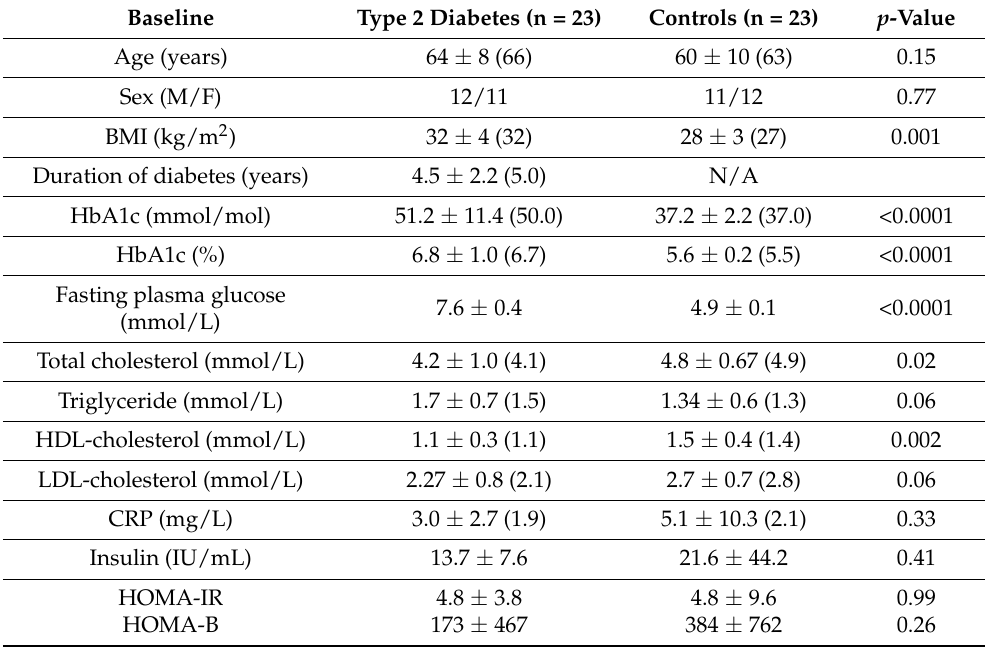
Table 1. Demographic and clinical characteristics of the study participants. Data are presented as mean ±